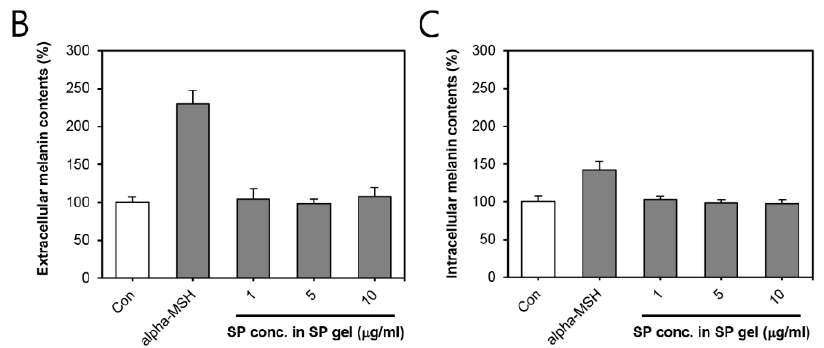
Figure 5. Effect of SP gel on melanogenesis in a keratinocyte-melanocyte co-culture system. ( A ) For immunofluorescence analysis of melanosome, co-cultured cells were treated with an increasing dose of SP gel (1–10 μ g/mL) for 72 h, and then fixed and analyzed by immunofluorescence-labeling with a human anti-HMB-45 antibody, finally incubating with fluorescein-conjugated mouse IgG. Nuclei were labeled with DAPI. Scale bar = 500 μ m. ( B , C ) Quantification of the effect of SP gel on melanin production in the co-culture system. Following incubation with increasing concentrations of SP gel (1–10 μ g/mL) for 72 h, the extracellular (B) and intracellular (C) levels of melanin were determined separately by measuring the absorbance at 405 nm. PBS or alpha-MSH was used as a negative or positive control, respectively. All values are represented as mean ± SD from three independent experiments. HMB, human melanoma black; IgG, immunoglobulin G; DAPI, 4 ′ ,6-diamidino-2- phenylindole; MSH, melanocyte-stimulating hormone.